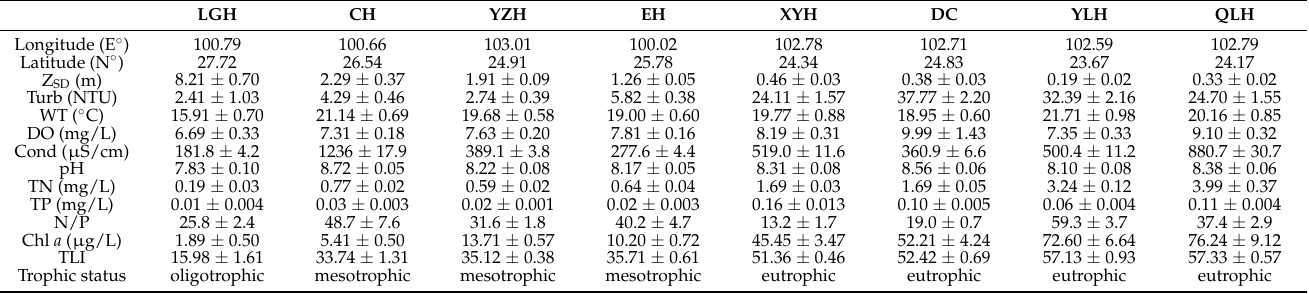
Table 1. Main limnological characteristics (mean ± SE) of the eight studied